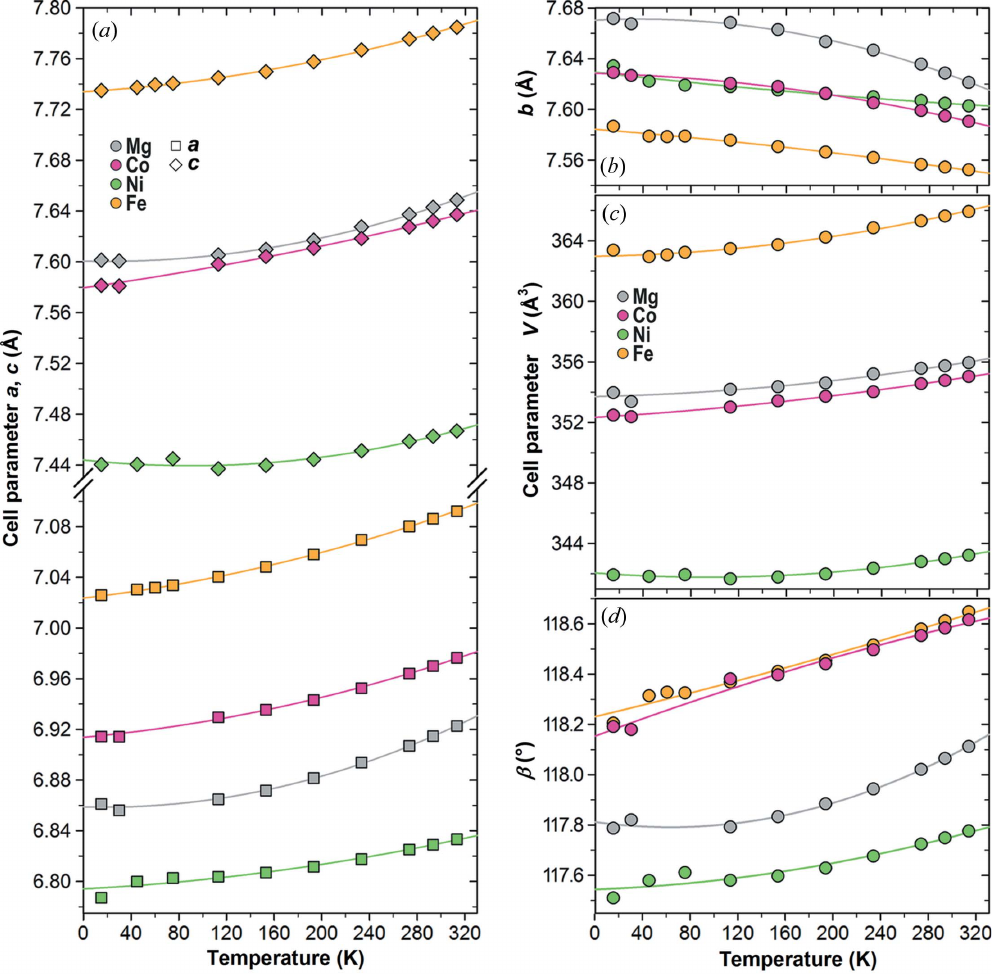
Figure 2 Unit-cell dimensions of kieserite-type compounds M 2+ SO 4 (cid:2) H 2 O ( M 2+ = Mg, Fe, Co, Ni) in the temperature range 15–313 K with lines representing the Fei-type EoS results (Table 1): ( a ) a and c axes; ( b ) b axes; ( c ) unit-cell volumes; and ( d ) monoclinic angle (cid:3) . For errors see the underlying data in Tables 1, S1 and